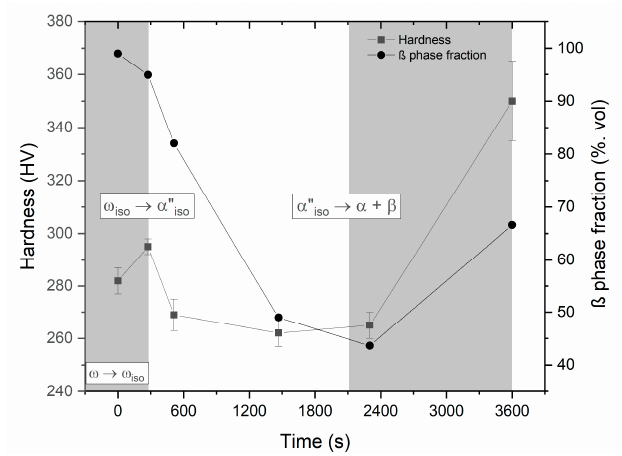
Figure 6. Hardness and β phase fraction evolution along the ageing treatment.